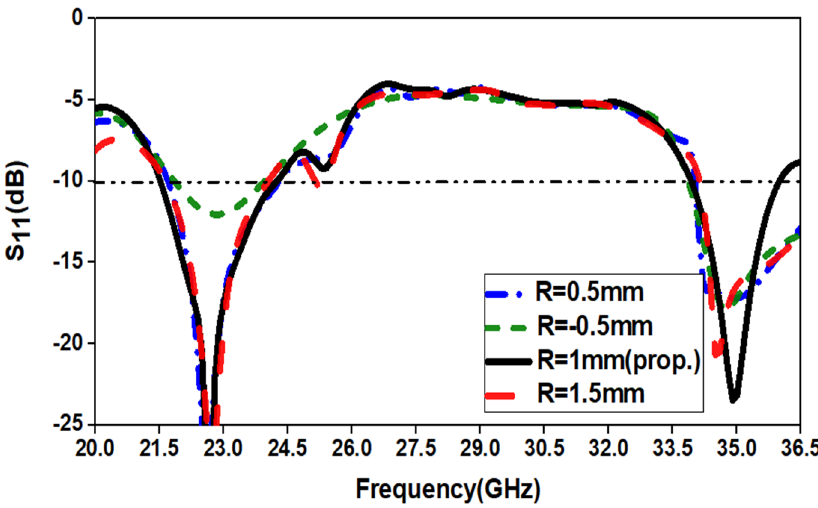
Figure 8. Analysis of variation in the incremental length R.